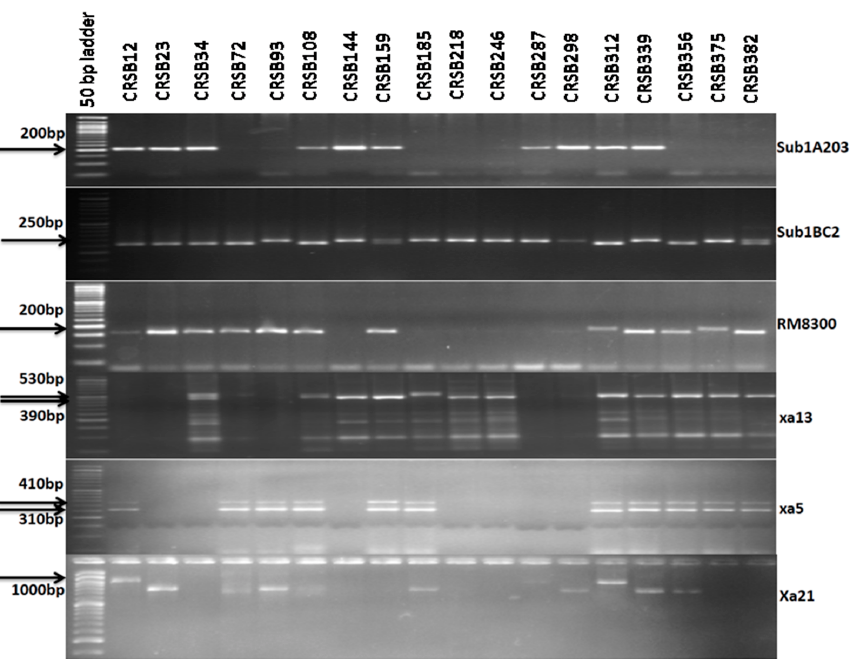
Figure 3. Representative electropherogram of BC 1 F 1 -derived lines of Ranidhan using submergence tolerance markers (Sub1BC2 and Sub1A203) and markers for bacterial blight resistance genes Xa21 , xa13 , and xa5 . The numbers at the top indicate the BC 1 F 1 generation of Ranidhan-derived lines. A 50 bp DNA ladder was used.